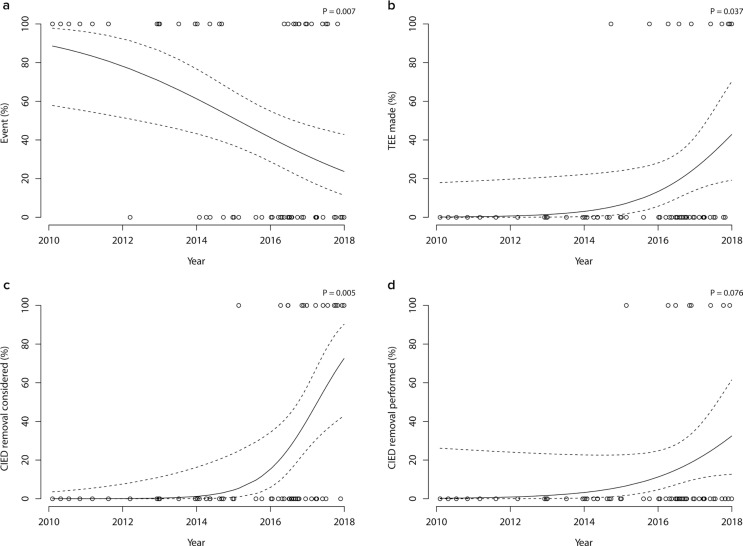
Trends in outcome and management during the study period. The probabilities of having an adverse event (a), having transesophageal echocardiography (TEE) performed (b), cardiac implantable electronic device (CIED) removal considered (c), and CIED removal performed (d), expressed as functions of the year of inclusion are illustrated by unadjusted logistic regression probability estimates. Individual measurements are indicated as circles. P-values were calculated by logistic regression for association with the year of inclusion.